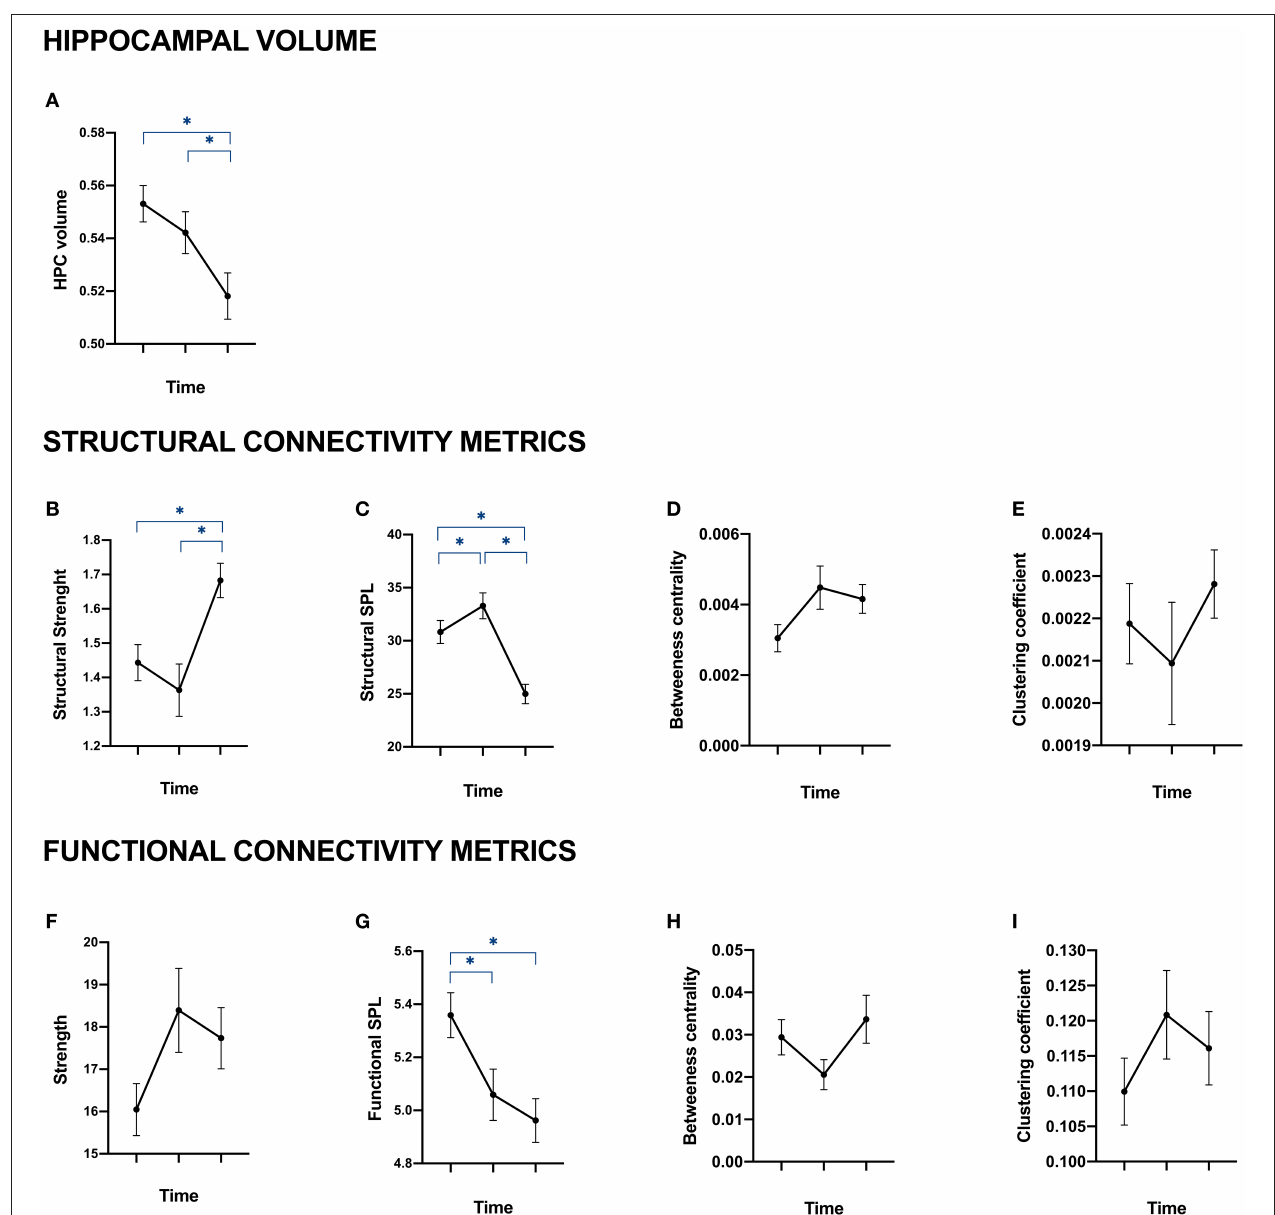
FIGURE 2 | Hippocampal volume, structural and functional connectivity of patients at baseline, year 1 and year 5. Data are provided as mean with standard error of the mean. (A) represents the evolution over time of patients’ total hippocampal volume (sum of right and left hippocampi). (B–E) represent the mean of right and left hippocampi structural connectivity through four metrics coming from graph theory: strength (B) , average shortest path length (C) , betweenness centrality (D) and clustering coefficient. (F–I) represent hippocampal functional connectivity through the same metrics: strength (F) , average shortest path length (G) , betweenness centrality (H) and clustering coefficient (I) . *Correspond to significant p -value after Bonferroni’s correction for multiple comparison on age-, sex, education-, and scanner-standardized